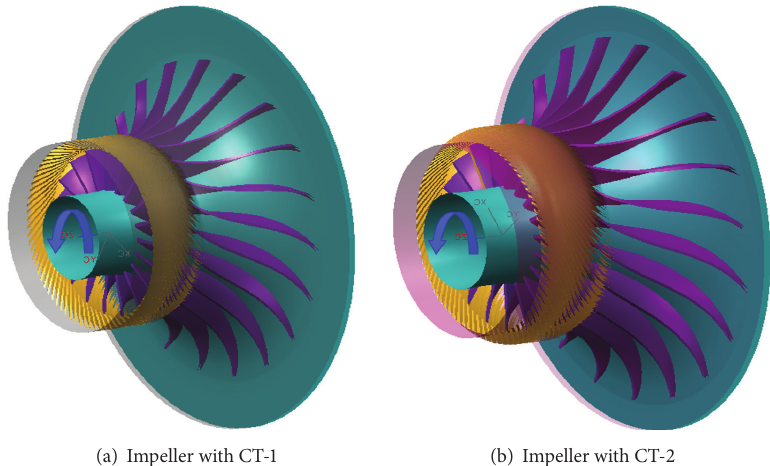
Figure 3: CAD models of impellers with CT-1 and CT-2 highlighting the difference in shape of casing around the inducer.